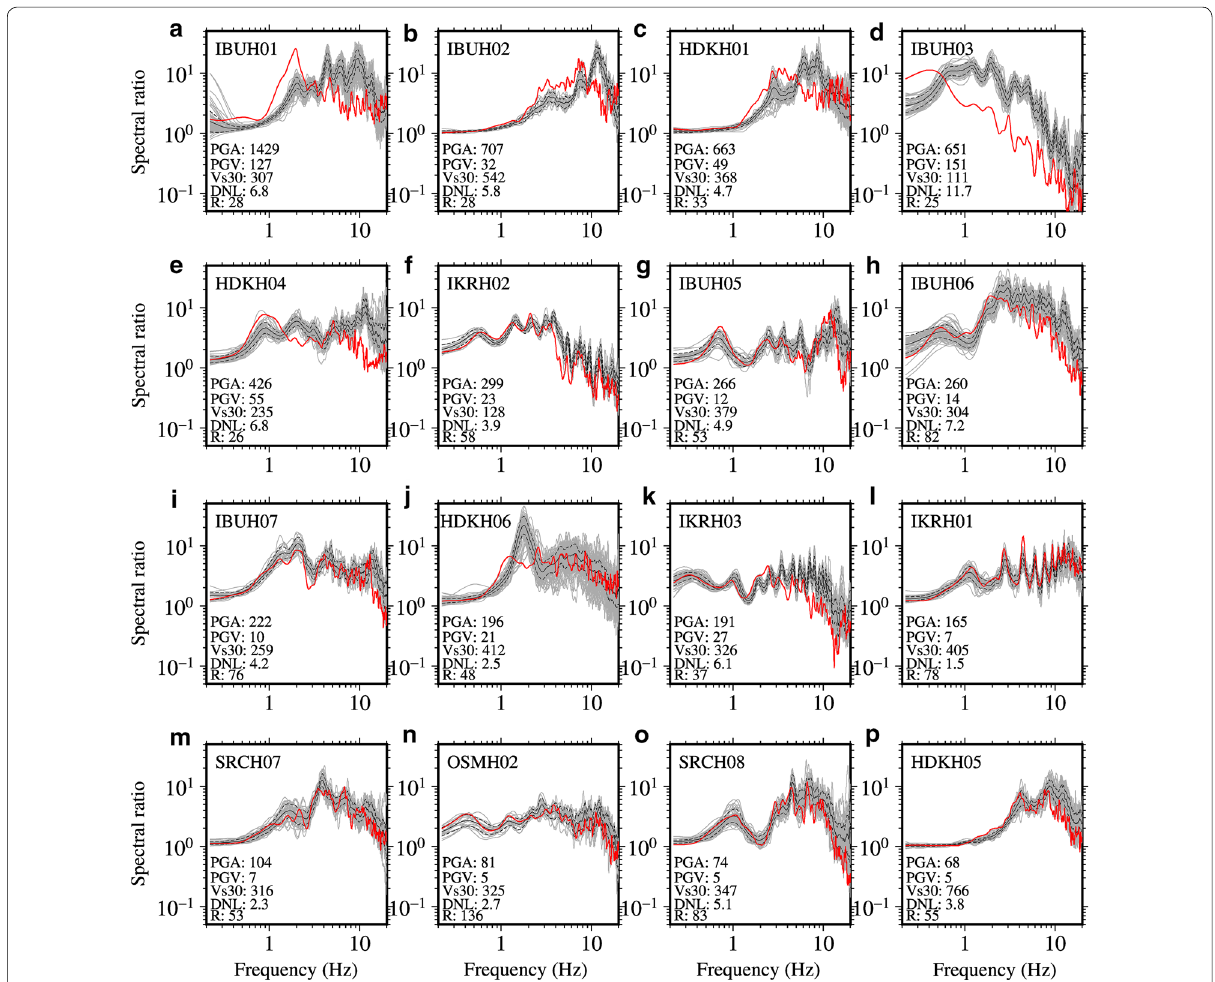
Fig. 5 Comparison of surface-to-borehole spectral ratios of horizontal component recordings during weak-motions (gray lines) and those during the mainshock (red lines) at KiK-net sites. The plots are arranged in order of decreasing horizontal vector PGAs in panels a – p , respectively. Solid black lines denote mean spectral ratios for weak-motions, and dashed gray lines denote one standard deviation. The PGA in units of cm/s 2 , PGV in units of cm/s, Vs30 in units of m/s, DNL values, and fault-to-site distance ( R ) in units of km are also included for each site. See Fig. 3 for site